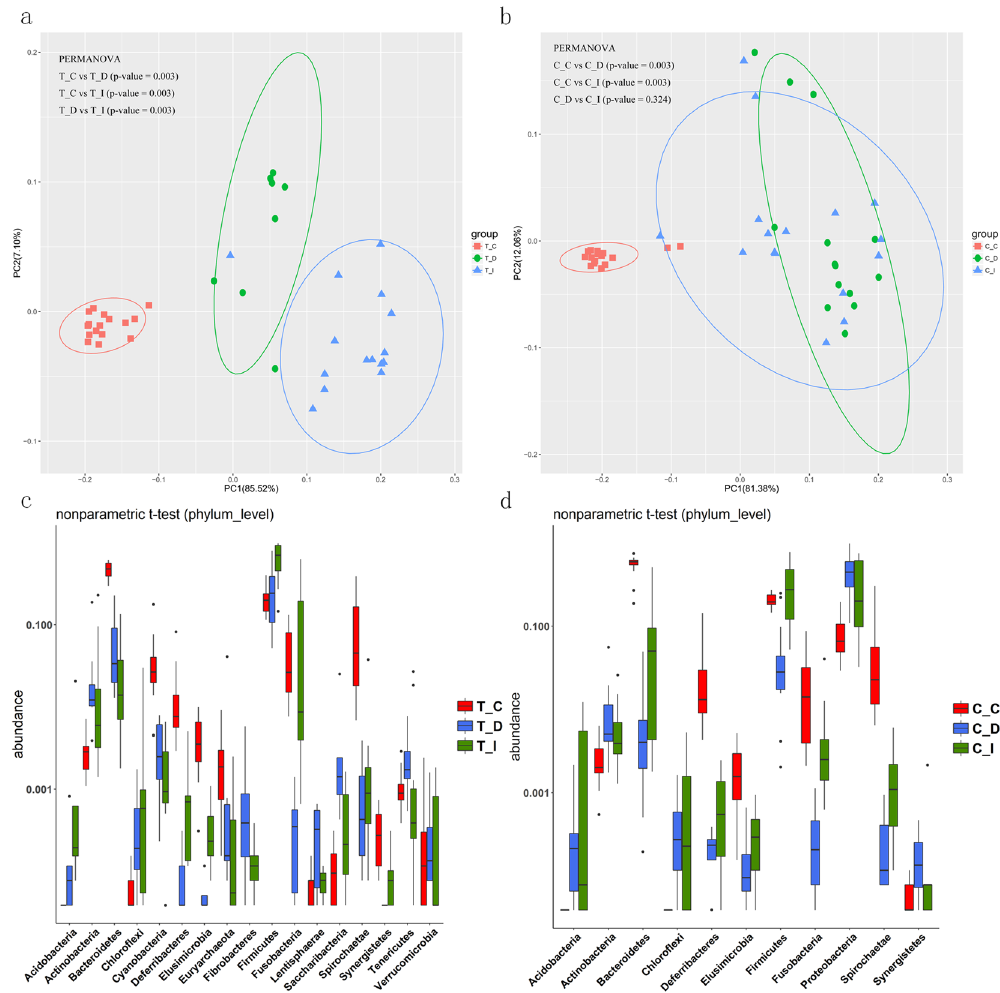
Figure 4. The overall luminal microbiota structures and compositions of three gut regions of Shaoxing ducks under the same rearing condition. ( a , b ) Principal Coordinate Analysis of Weighted UniFrac Distances of the duodenum, ileum, and cecum luminal samples under each rearing condition. ( c , d ) Comparison of luminal microbiota compositions of the three gut regions at the phylum level under the 2 rearing conditions was performed by Nonparametric Wilcox t-test